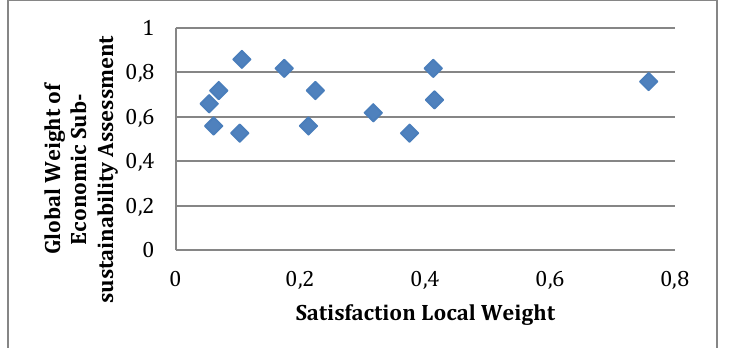
Figure 25: Global weight vs. satisfaction local weight of economic sub-sustainability assessment, macro-scale literature based